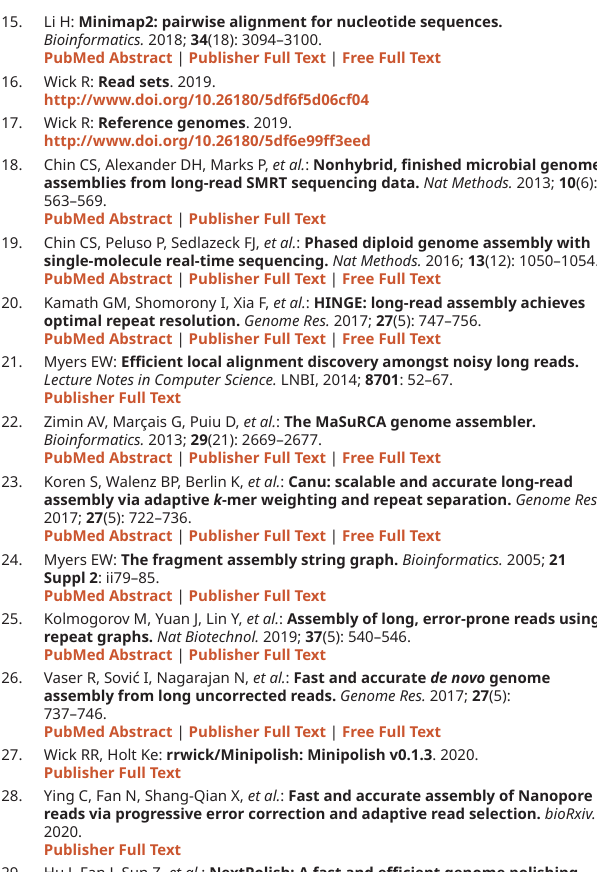
• Figure S7. Contiguity of the simulated read set assemblies plotted against Badread parameters for each of the tested assemblers. These plots show how well the assemblers tolerate different problems in the read sets. (A) Mean read depth (higher is better). (B) Max read identity (higher is better). (C) N50 read length (higher is better). (D) The sum of random read rate and junk read rate (lower is better). (E) Chimeric read rate (lower is better). (F) Adapter sequence length (lower is better). (G) Glitch size/skip (lower is better). • Figure S8. Plasmid completion for the simulated read set assemblies for each of the tested assemblers, plotted with plasmid length and read depth. Solid dots indicate completely assembled plasmids (contiguity ≥ 99%) while open dots indicate incomplete plasmids (contiguity <99%). Percentages in the plot titles give the proportion of plasmids which were completely assembled.